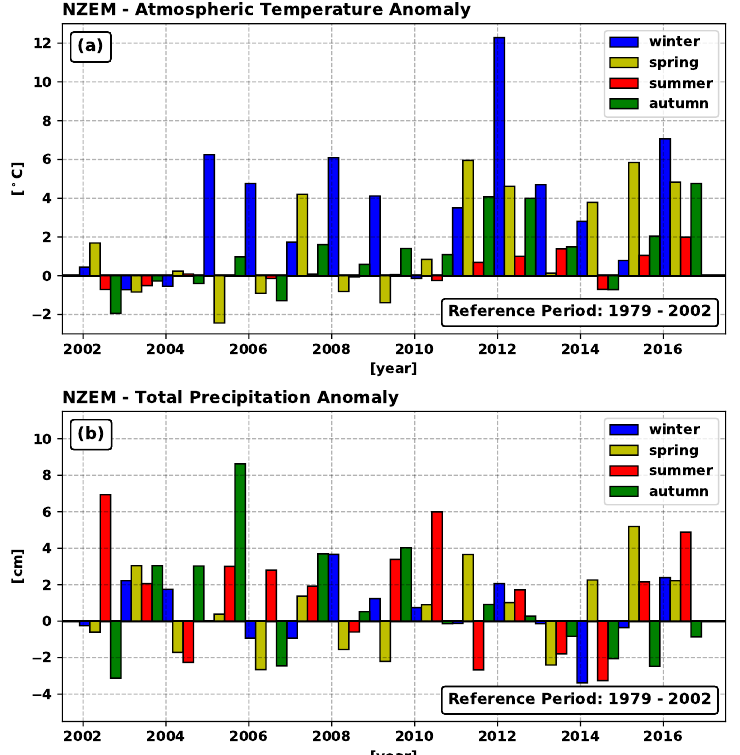
Figure 9. ( a ) Seasonal atmospheric Temperature Anomaly (ERA-Interim—monthly mean 2 m temperature) calculated using the interval between 1979 and 2002 as a reference period. ( b ) Total seasonal precipitation (ERA-Interim—Total Precipitation Synoptic Monthly Means) anomaly calculated using the time period 1979–2002 as a reference